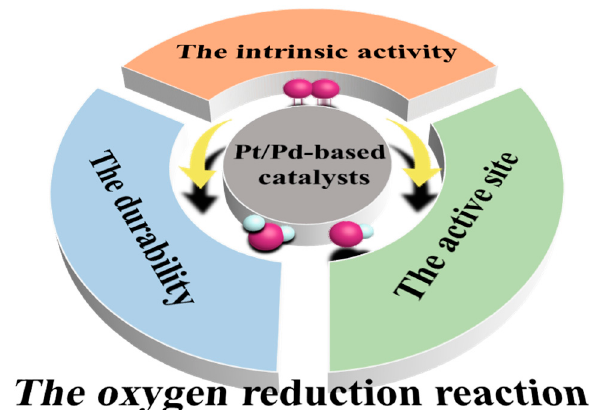
Figure 1. The Schematic of the optimizing strategies for Pt/Pd-based